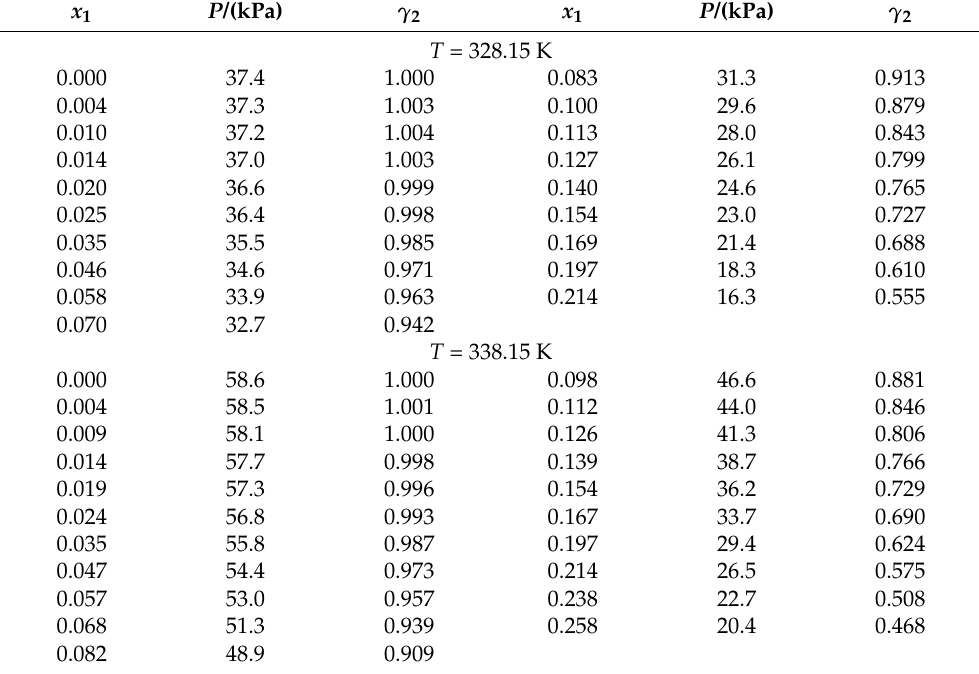
Table 4. Experimental P–T–x data for the {[N 1,2,2,2 ][DMP] (1) + Ethanol (2)} binary system: equilibrium temperature, T /K; equilibrium pressure, P /kPa, ionic liquid mole fraction, x 1 ; activity coefficient of ethanol, γ 2 a